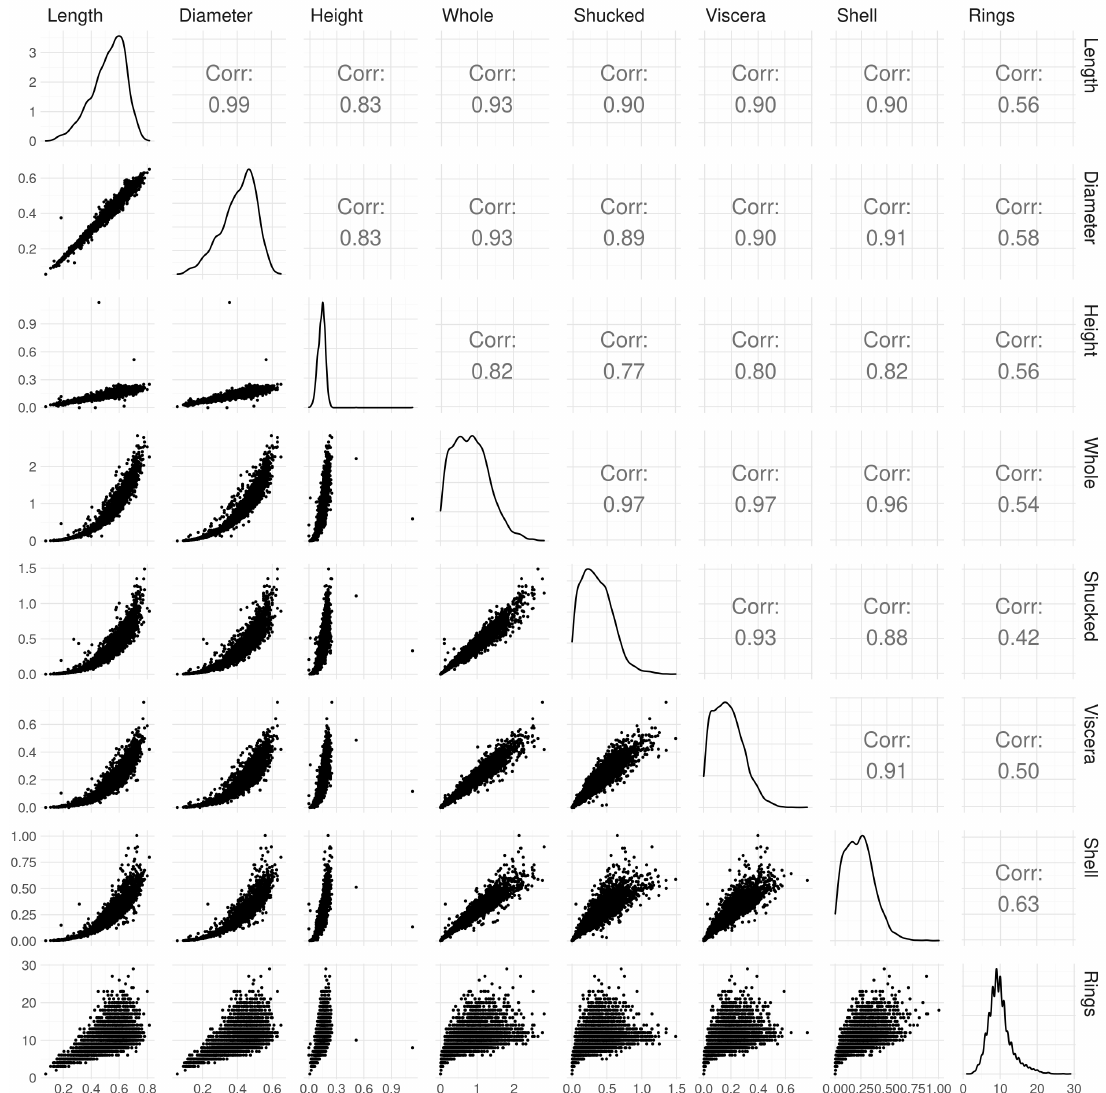
Figure 4: Pairwise scatter plots, marginal density functions and pairwise correlation coefficients for the explanatory variables and the response